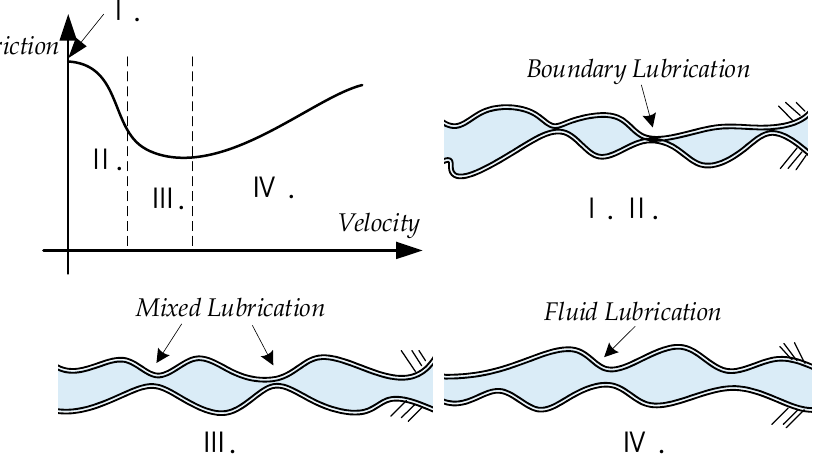
Figure 2. Stribeck curve diagram: ( Ⅰ ) Static friction; ( Ⅱ ) Boundary lubrication; ( Ⅲ ) Partial fluid lu- brication; ( Ⅳ ) Full fluid lubrication.